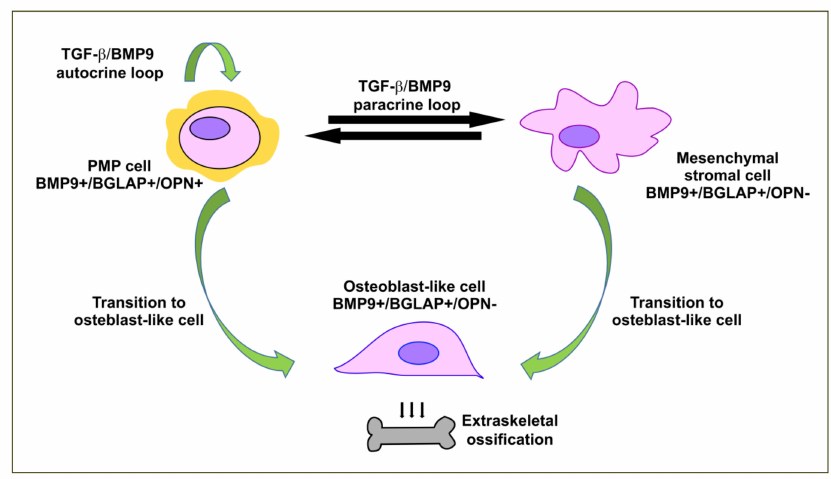
Figure 4. Ectopic ossification in PMP. The tumor microenvironment is composed of cellular and acellular elements, whose interaction may create a dynamic landscape in which EMP takes place. Cytokines and chemokines initially expressed by tumor cells and then induced in the attracted stromal and immune cells may promote cell plasticity. In the context of PMP, TGF- β / BMP9 secreted by PMP cells and expressed by stromal cells may induce EMT in an autocrine and / or paracrine loop. Tumor cells, after having transitioned into a more mesenchymal state, may di ff erentiate towards an osteoblast-like phenotype. In a similar manner, mesenchymal stromal cells, influenced by the same stimuli, may undergo a transition to osteoblast-like cells. These cells were shown to express osteoblastic markers and are very likely responsible for pathologic formation of extraskeletal bone. TGF- β / BMP9: Transforming growth factor-beta / Bone morphogenetic protein 9; BGLAP: Bone γ -carboxyglutamic acid-containing protein or Osteocalcin; OPN: